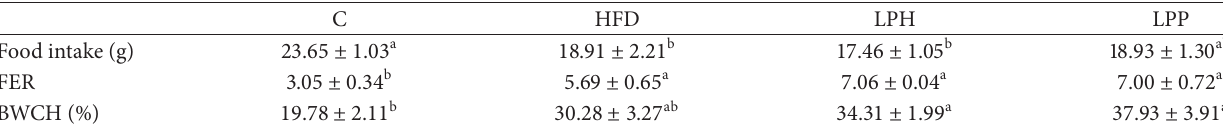
Table 2: Food intake, FER, and BWCH.